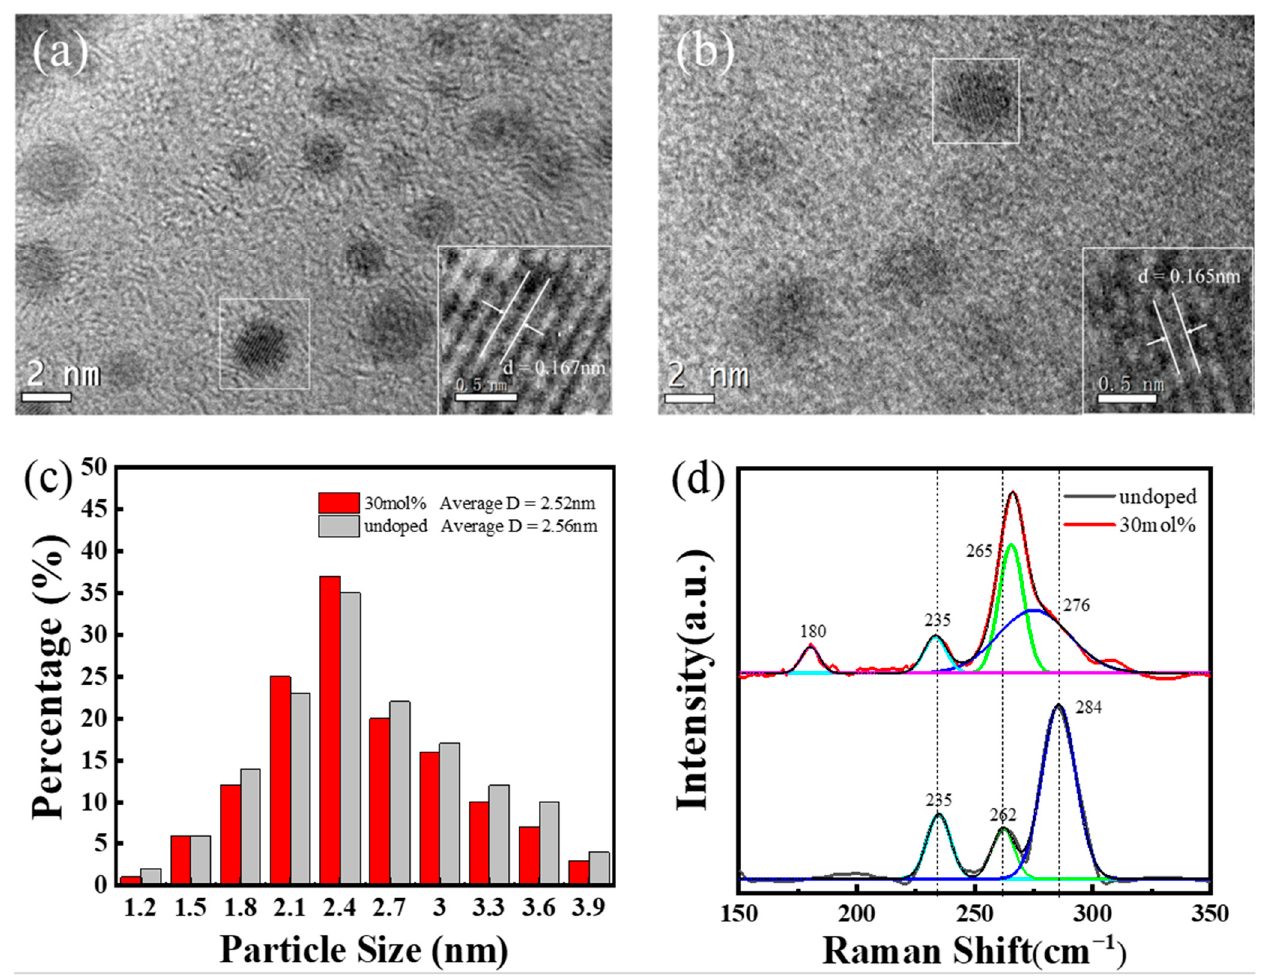
Figure 2. ( a ) High-resolution TEM image of Cs 3 Bi 2 Cl 9 QDs; ( b ) high-resolution TEM image of Cs 3 Bi 2 Cl 9 : Ce 30% QDs; ( c ) particle size distribution of Cs 3 Bi 2 Cl 9 and Cs 3 Bi 2 Cl 9 : Ce 30% QDs; ( d ) Raman spectra of Cs 3 Bi 2 Cl 9 and Cs 3 Bi 2 Cl 9 : Ce 30% QDs. The upper part: the red line is the experimental data of the sample doped with 30% Ce, and the other color lines are single-peak fitting, The lower part: the black line is the experimental data of undoped samples, and the other color lines are single-peak fitting.